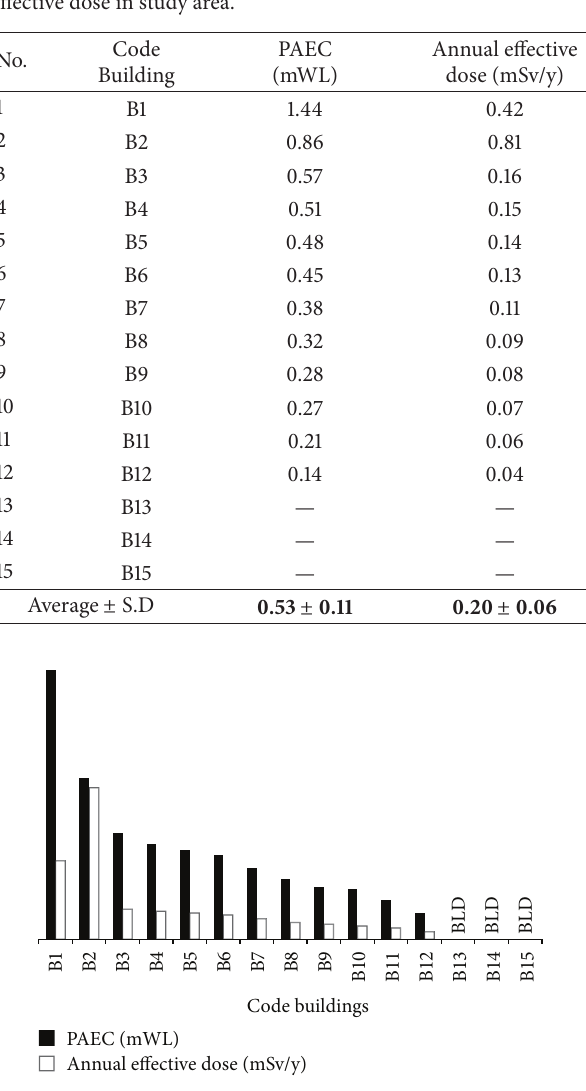
Table 2: Results of thoron concentrations in study area.